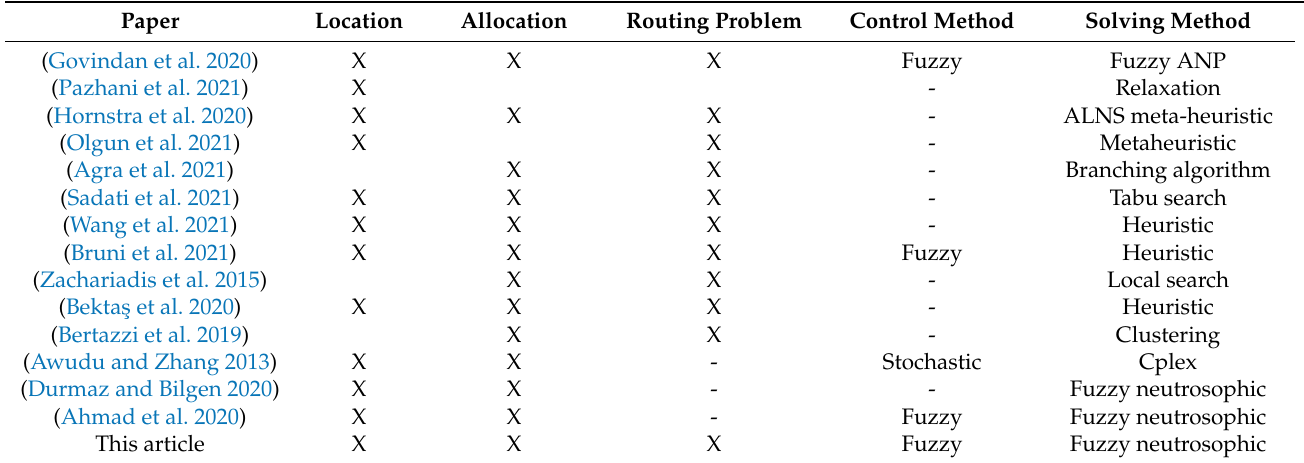
Table 1. An overview of the most critical research